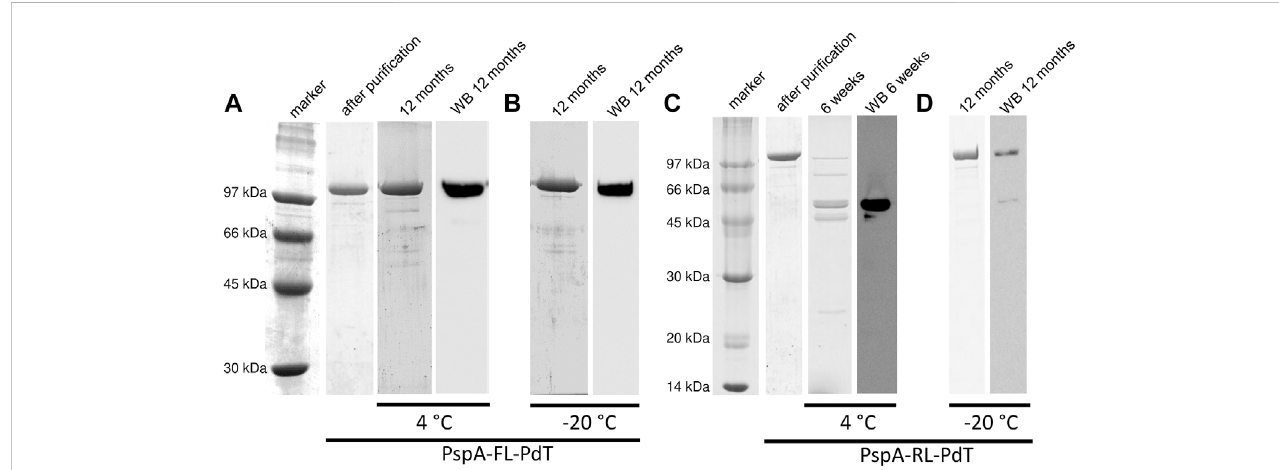
FIGURE 5 StabilityperiodicevaluationofthefusionproteinsbySDS-PAGEandWesternblot(WB). (A,B) rPspA-FL-PdTstoredat4 ° Cand − 20 ° C,respectively.rPspA- FL-PdT was evaluated just after puri fi cation (1 day) and periodically up to 12 months after puri fi cation. (C, D) rPspA-RL-PdT stored at 4 ° C and − 20 °